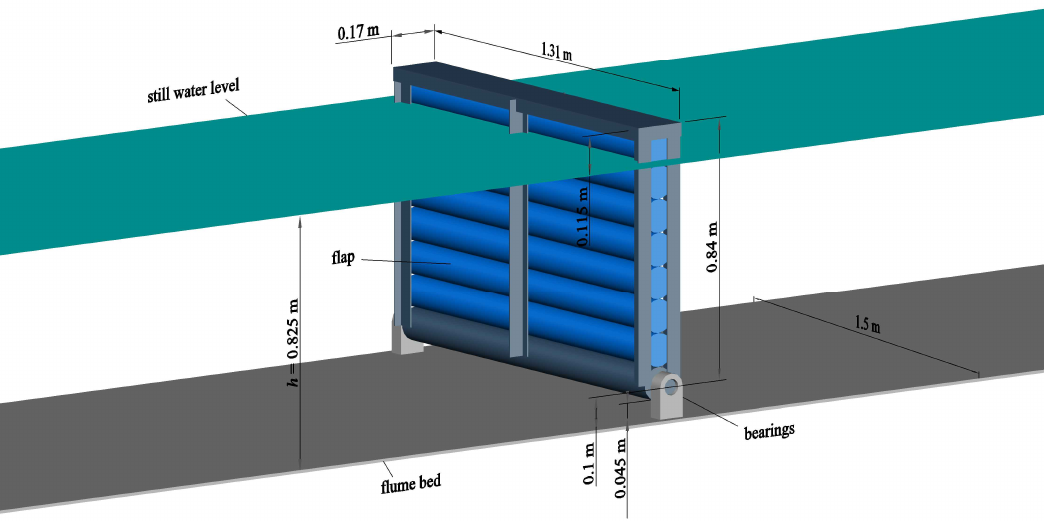
Figure 4. Sketch of the OWSC model in the wave